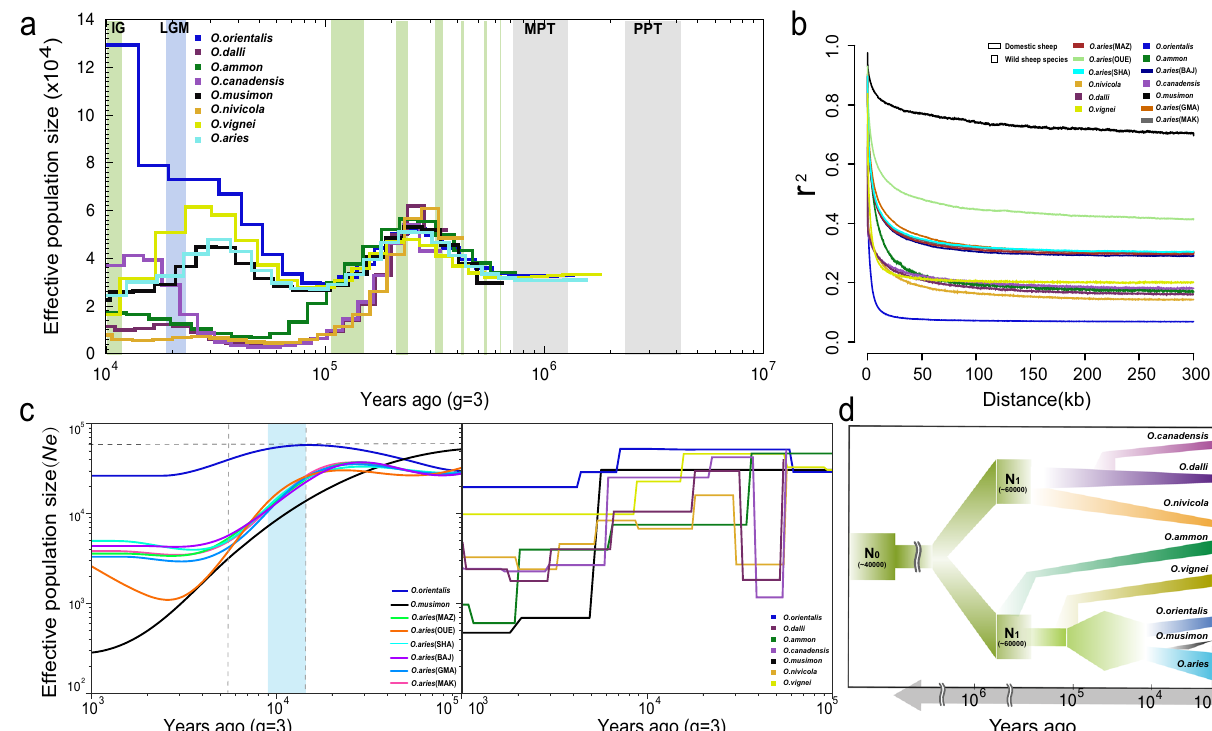
Fig. 3 Demographic inference. a Ancestral dynamic change of effective population size inferred by PSMC program for eight high-depth genomes. Colors of the lines indicated different species. Plots were scaled using a mutation rate of 2.5 × 10 -8 per-site per generation and generation time (g) of 3. Light green shading indicates interglacials (IG) in the Pleistocene and Holocene, and light blue indicated as the Last Glacial Maximum (LGM) and gray shading indicates the mid-Pleistocene transition (MPT) and the Plio-Pleistocene transition (PPT). b LD decay analysis for seven wild species (marked as rectangles) and six domestic breeds (marked as squares). c Dynamic change of effective population size inferred by the SMC ++ program for Asiatic and European mou fl on and six domestic breeds (left panel) and seven wild species (right panel), the blue shading indicates the period of domestication and the gray vertical dashed line is the potential split time point of European and Asiatic mou fl on. d Dynamic change of effective population size over time for all Ovis species. Source data for b were presented in Supplementary Data